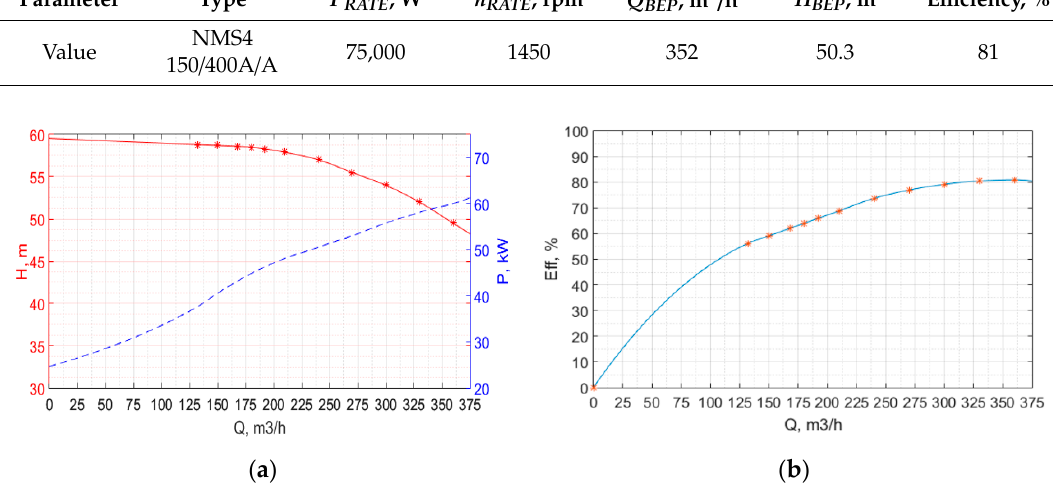
Figure 2. Flow-time profile for constant flow systems [17,18].